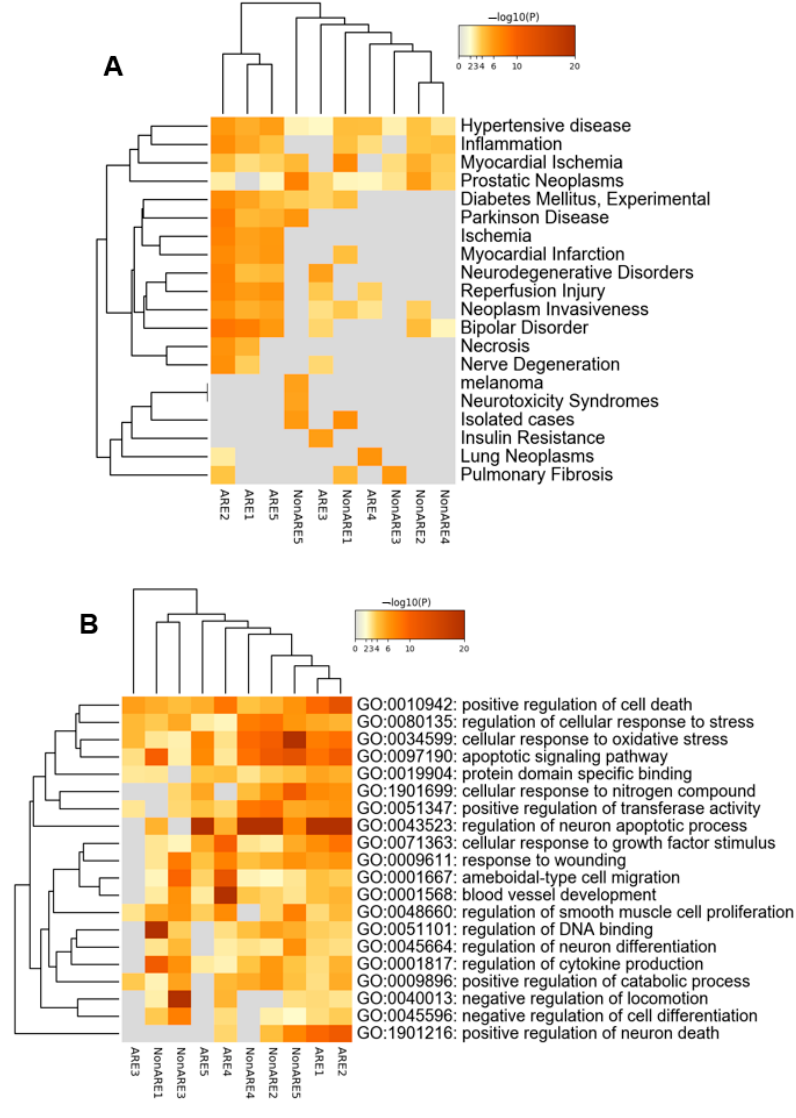
Figure 3. ( A ) Enrichment of disease terms by gene signatures that contain either ARE or non-ARE genes. ( B ) Heatmap of enriched biological processes in ARE and non-ARE containing gene signatures.